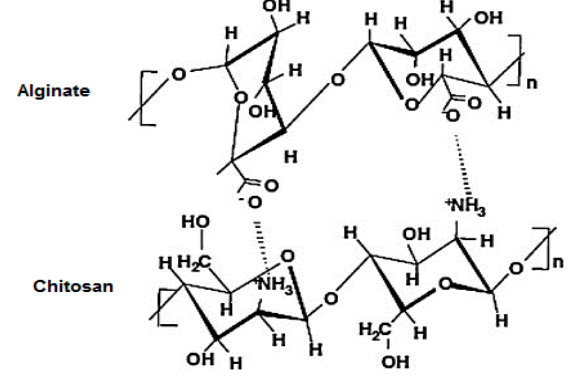
Figure 1. Structure of chitosan–alginate PEC.